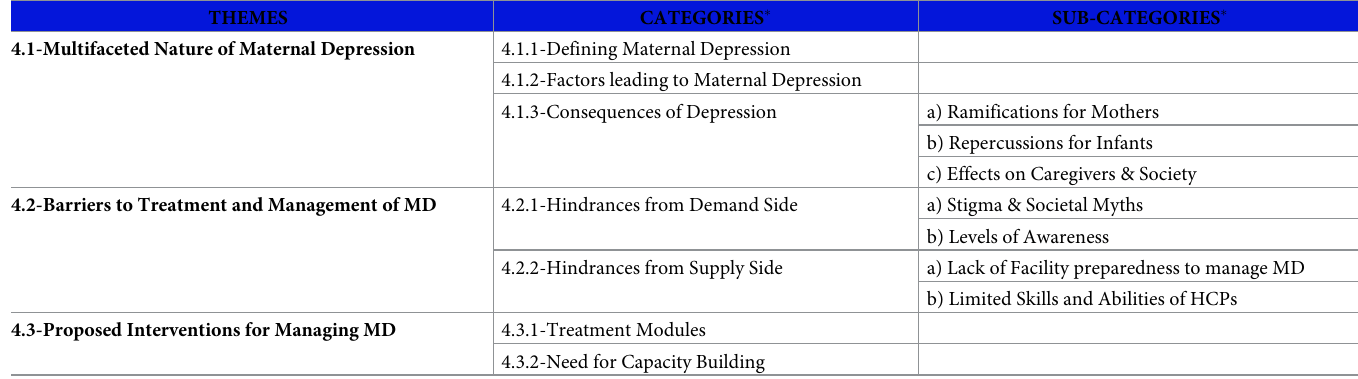
Table 3. Codes developed for data